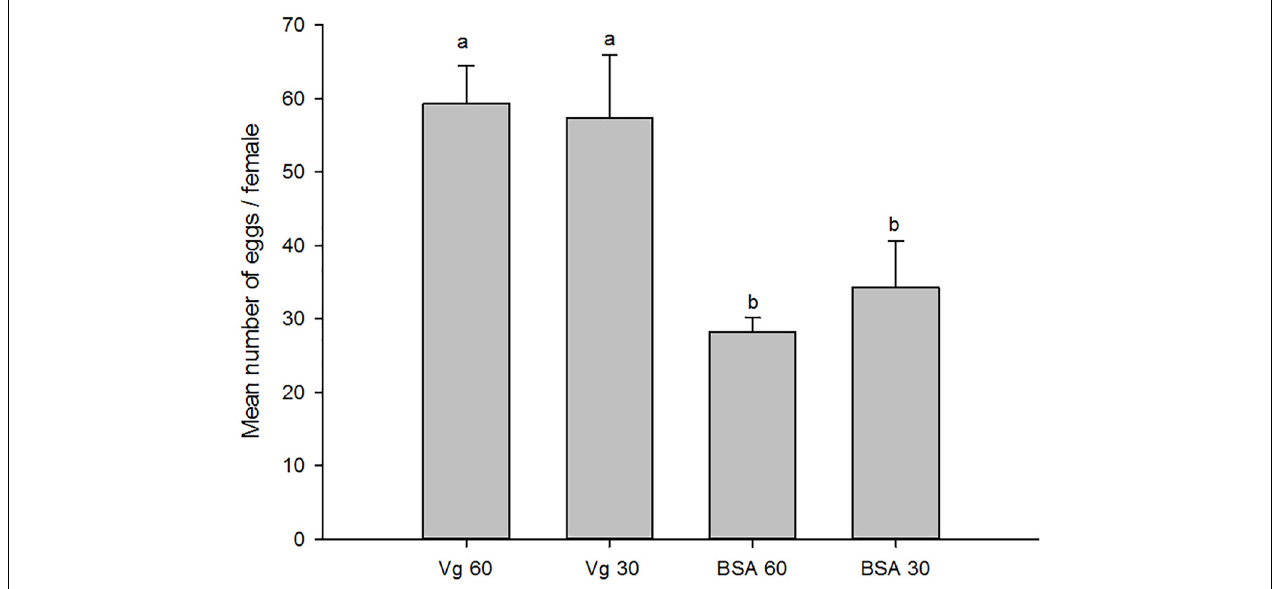
FIGURE 7 | Total H. axyridis egg production in groups of the Vg- and BSA-supplemented artificial diets during 1 month period. The data were analyzed by SPSS. The egg production was shown as the means ± SEs.